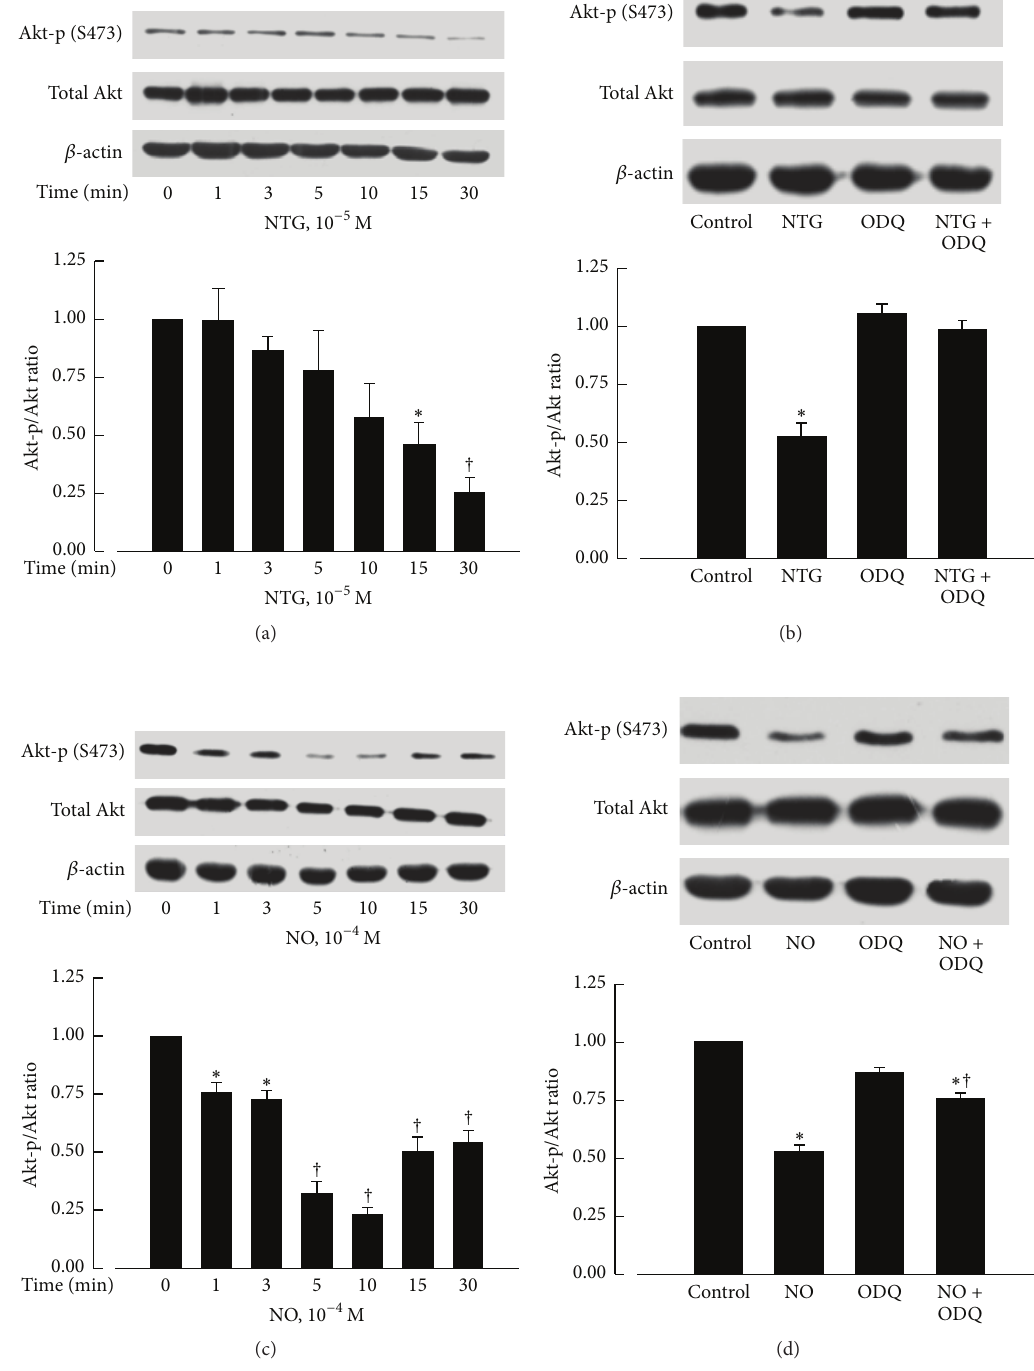
Figure 2: Effects of NTG and DETA NONOate on protein levels of Akt-p (S473) and total Akt. Akt-p (S473) was significantly decreased after NTG (10 −5 M) treatment for 15min (a) or DETA NONOate (NO, 10 −4 M) treatment for 1min (c), which could be recovered by ODQ (3 × 10 −5 M; (b) and (d)). The upper panels are western blots. The lower panels are the summaries of densitometric scanning of proteins expressed as ratio of Akt-p (S473) to total Akt. Data shown as means ± SEM; 𝑛 = 6 –8 for each group. ∗ significantly different from the control group ( 𝑃 < 0.05 ); † significantly different from the control group ( 𝑃 < 0.01 , (a) and (c)); † significantly different from the NO group ( 𝑃 < 0.05 ,